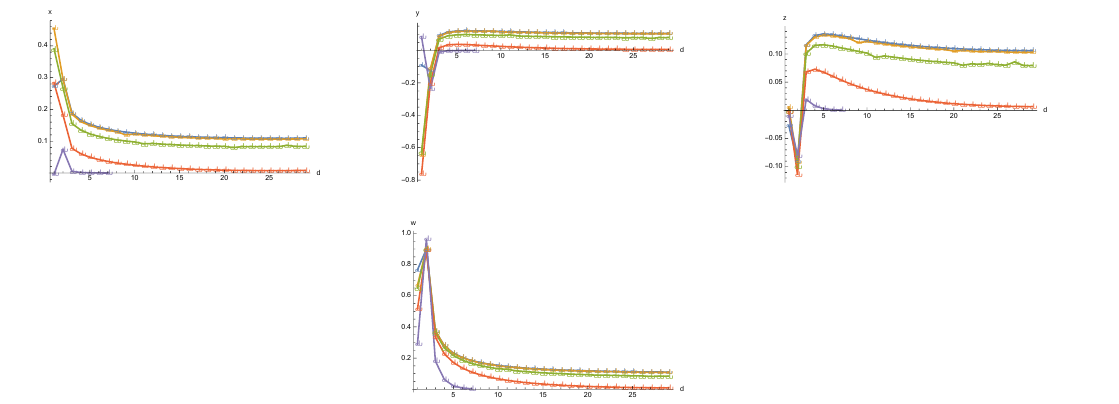
Figure 11 . The plots of the optimized value of the parameter x; y; z; w which gives the minimum of S in the setup of j A j = j B j = 2. In the (cid:12)rst graph, from the above to the bottom, the mass A ~ A varies m = 0 : 0001 ; 0 : 001 ; 0 : 01 ; 0 : 1 ;